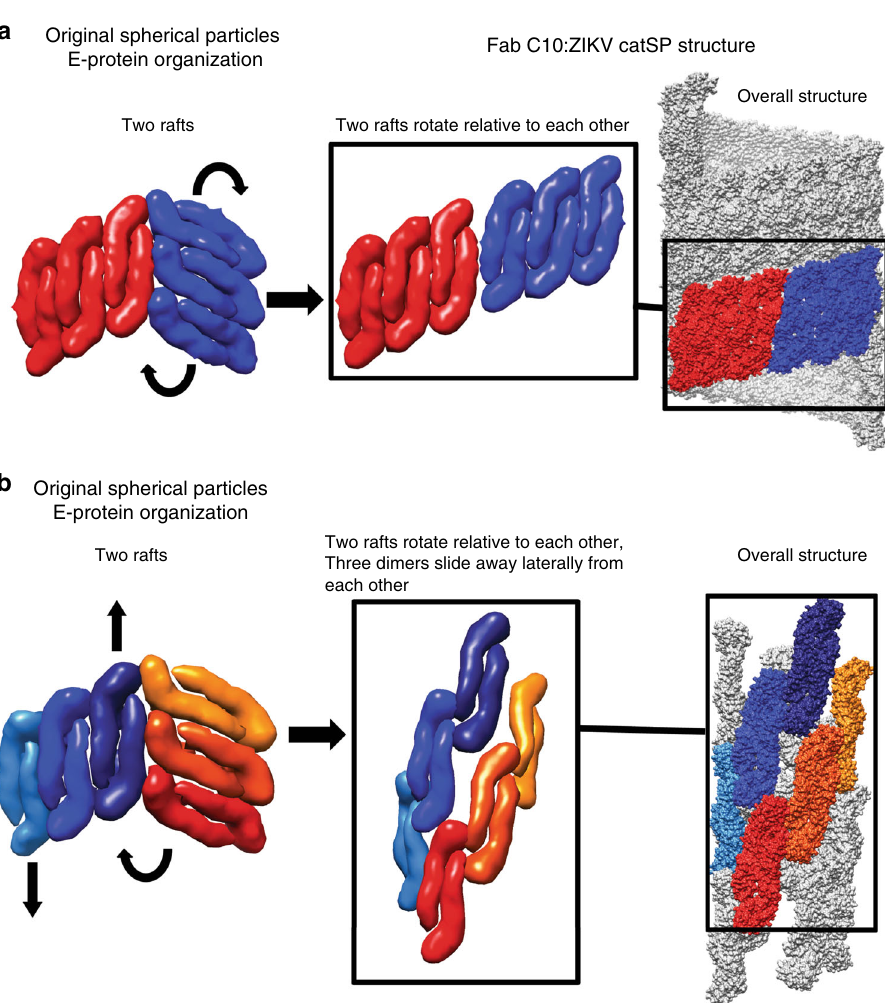
Fig. 4 E proteins rearrangement on the original spherical particles to form catSP and clubSP. a The Fab C10:ZIKV catSP structure shows when the E protein raft is locked by the Fabs as observed previously by the near-atomic resolution cryoEM structure of Fab C10:ZIKV spherical structure 13 , the rafts of the original spherical ZIKV particle (left) at elevated temperatures have to rotate relative to each other (curved arrows in left panel) to generate catSP helical structure (middle and right panels). Two rafts are shown in red and blue. b The Fab C10:DENV3 clubSP structure shows that Fab C10 does not lock the E dimers within the raft in DENV3, as the dimers have moved relative to each other. This suggests that, when incubating the spherical particles at elevated temperatures, structural rearrangement may include rotation of the rafts relative to each other (as observed in ZIKV catSP, curved arrow in left panel) and also the lateral motions (indicated by vertical arrows in left panel) of the E protein dimers, achieving the fi nal helical structure (middle and right panels). These suggest that the inter-dimer interactions between the E proteins are also weak in addition to their inter-raft interactions. Two rafts each with three dimers are colored as different shades of red or blue and displayed as surface